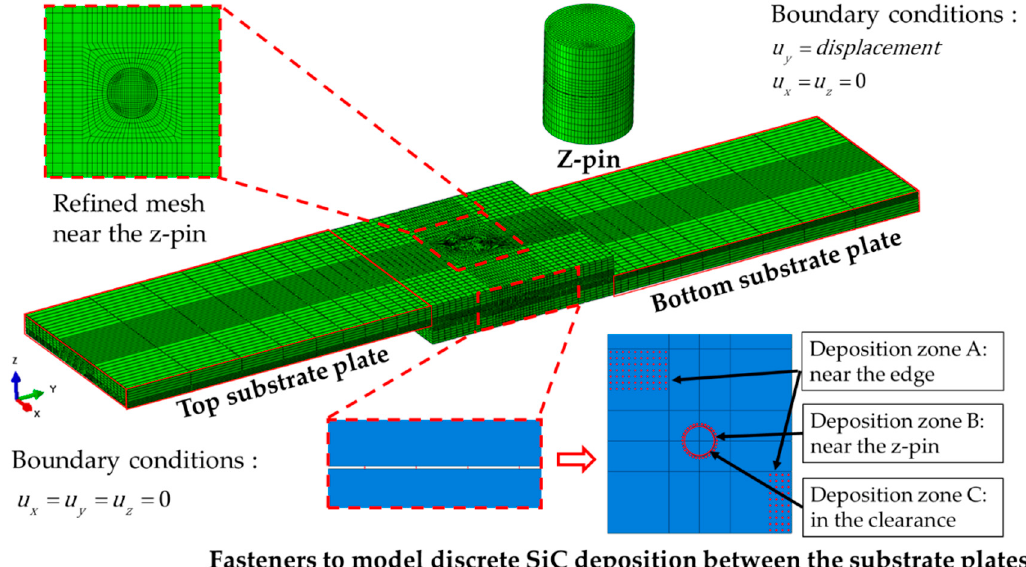
Figure 9. Numerical model description of the C/SiC z-pinned/bonded hybrid single-lap